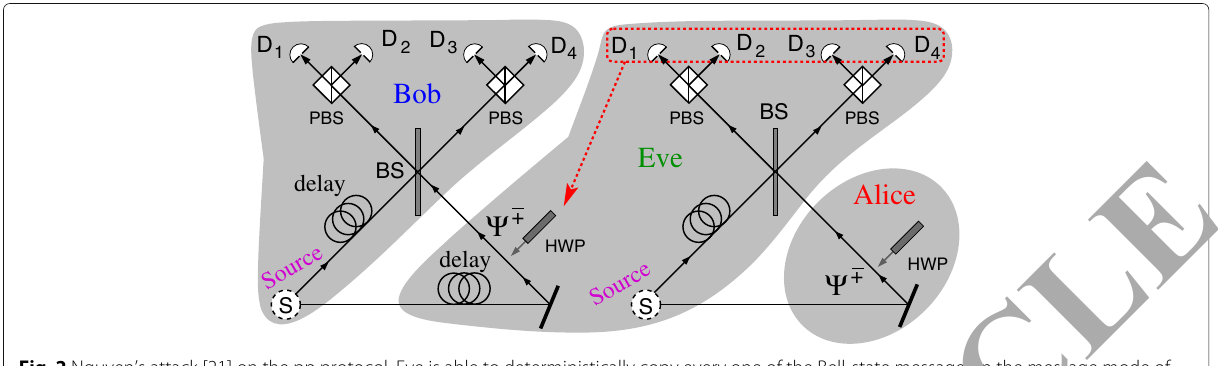
Fig. 2 Nguyen’s attack [21] on the pp protocol. Eve is able to deterministically copy every one of the Bell-state messages in the message mode of the pp protocol